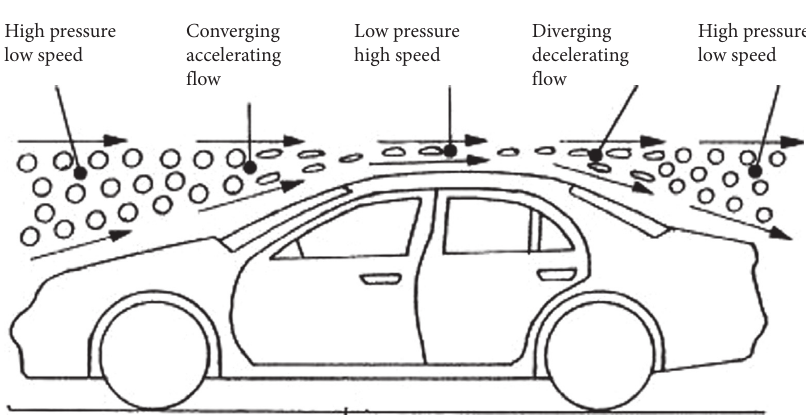
Figure 2: View of changes in pressure and velocity of the liquid passing through the car body